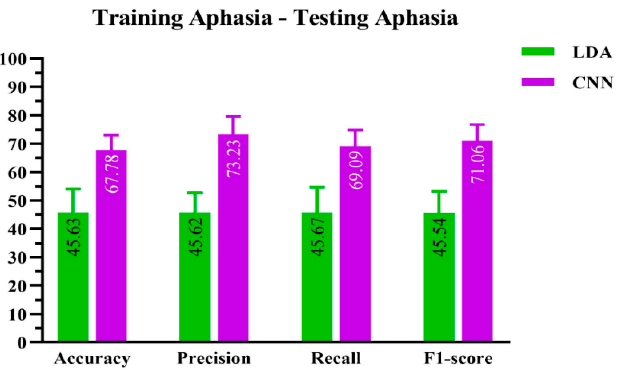
Figure 4. Performance evaluation of CNN and LDA machine learning-based algorithms on the aphasic dataset.